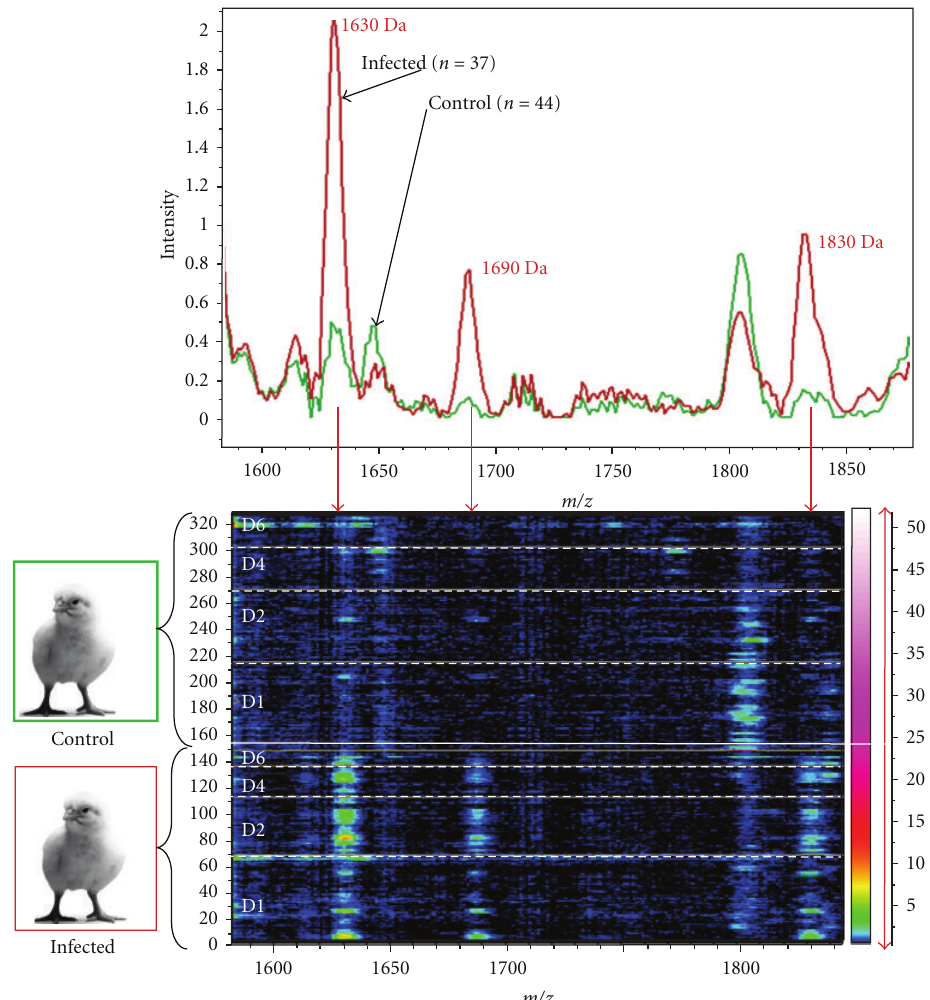
Figure 4: Example of mean spectrum obtained by matrix-assisted laser desorption ionization time of flight mass spectrometry (WCX) from seric samples of infected and control